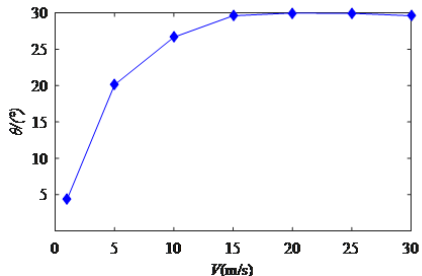
Fig. 5. Change of wind attack angle of positive